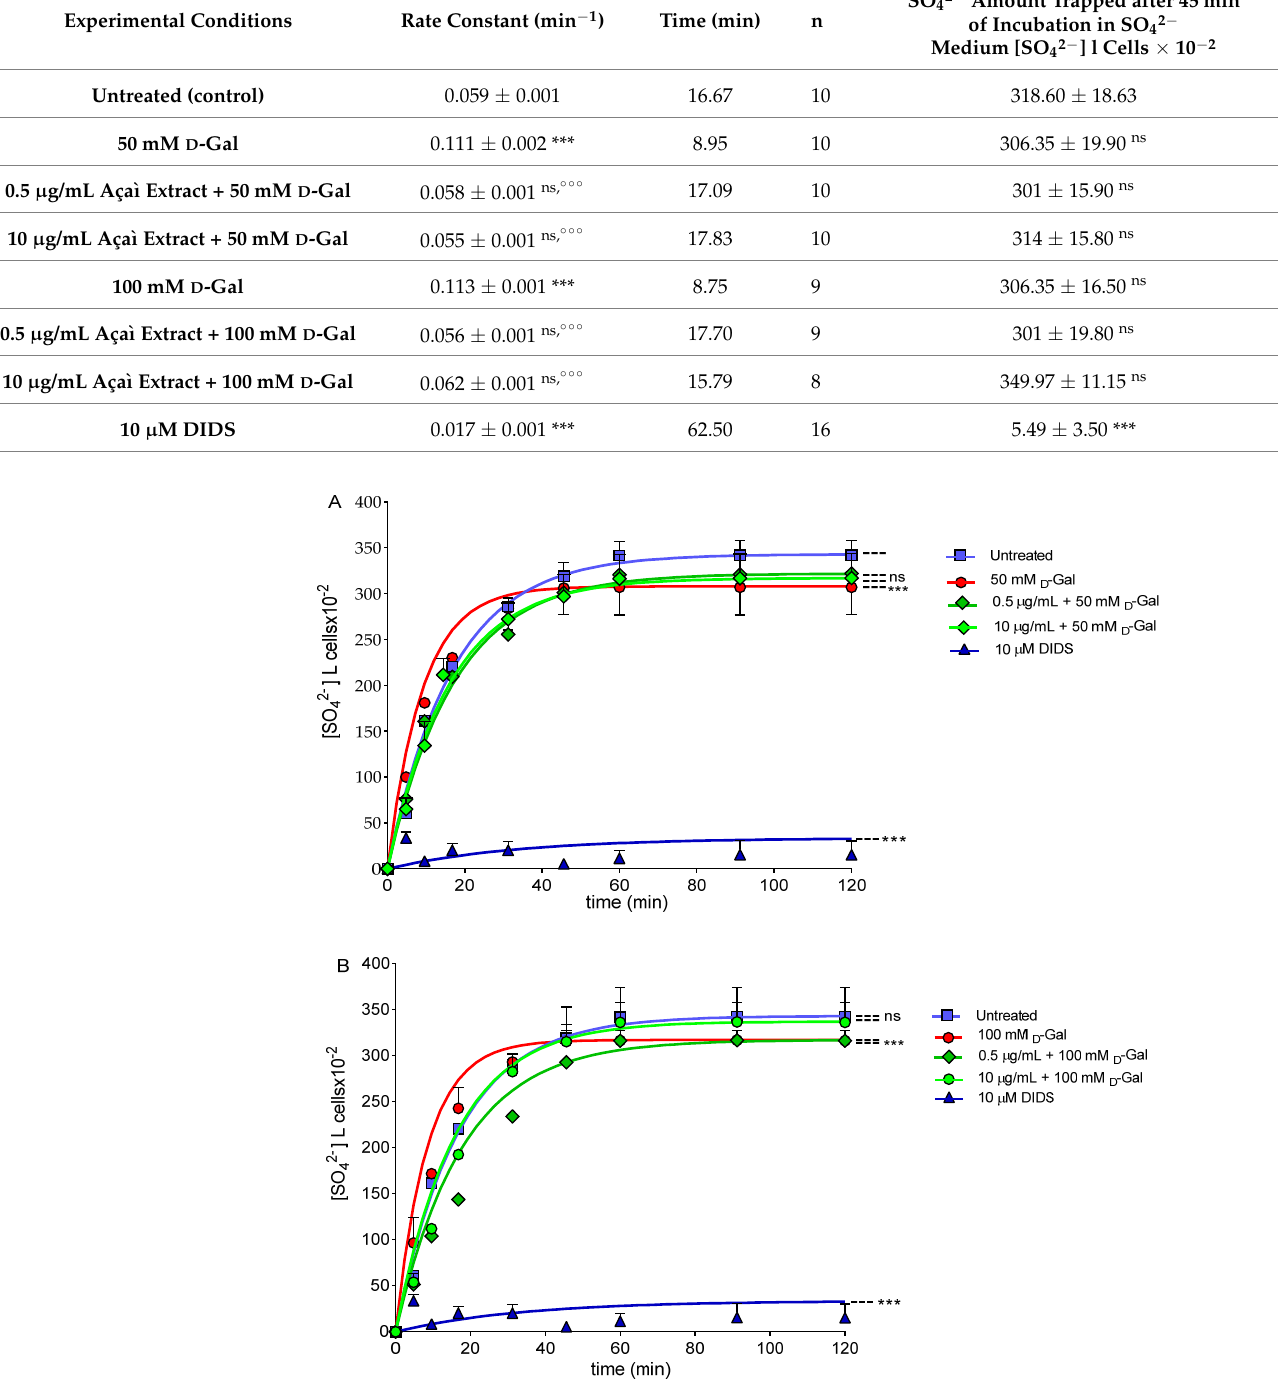
Figure 11. Time course of SO 4 2 − uptake. Erythrocytes were left untreated (control) or treated with ( A ) 50 or ( B ) 100 mM D-Gal with or without pre-exposure to 0.5 or 10 µg/mL freeze-dried Açaì extract (pre-incubation for 1 h), or 10 µM DIDS. ns, not statistically significant versus control; ***, p < 0.001 versus control, one-way ANOVA followed by Bonferroni’s post hoc test.